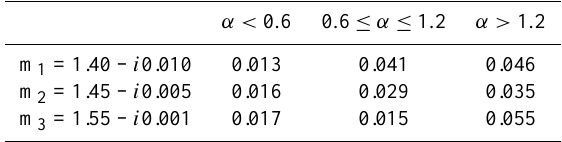
Table 3. Root-mean-square distances of retrieved q a ( 60 ◦ ) values from the curves corresponding to m 1 , m 2 , and m 3 refractive indices (Fig. 9) for three different spans of α